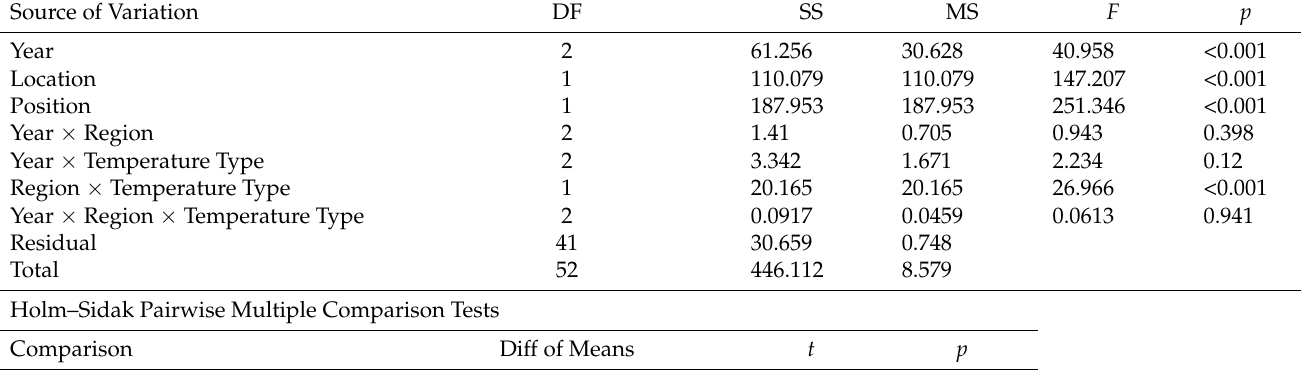
Table 1. Summary table for three-way ANOVA test of summer land temperatures (2 m air) and SST during intertidal survey years. Region refers to northern versus southern GoM, defined by survey locations. Temperature Type refers to land (2m air) temperature versus sea surface temperature (SST).